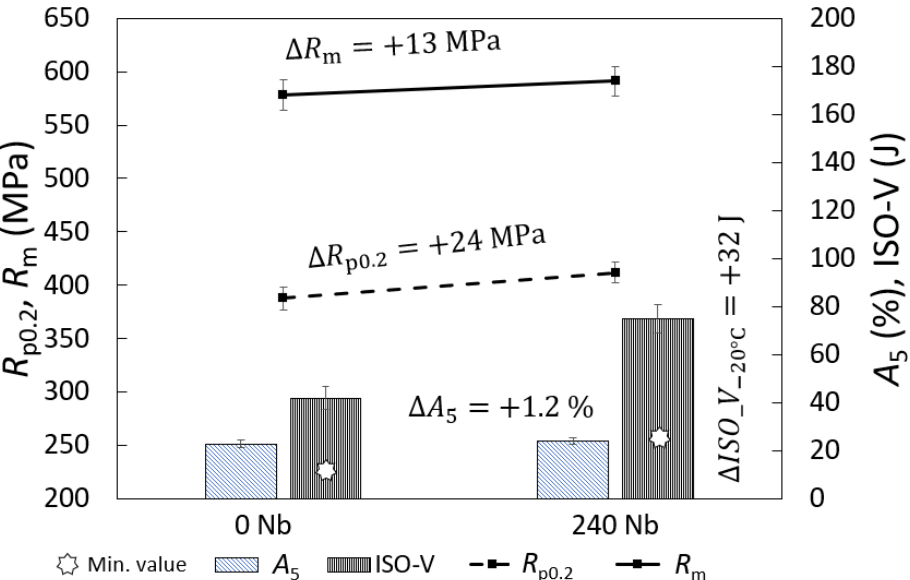
Figure 10. Tensile strength and transverse low-temperature toughness properties ( − 20 ◦ C) for 0 Nb and 240 Nb in as-rolled state after partial SRX in the roughing phase. Outliers for toughness are marked with star signs.